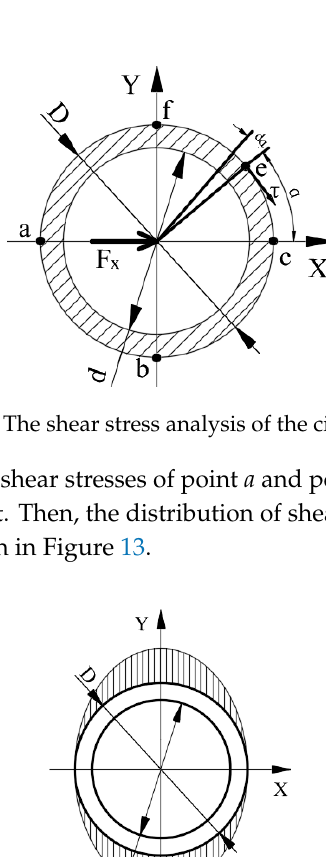
Figure 13. The distribution of shear stress values of the points in the outside surface of the circular ring.